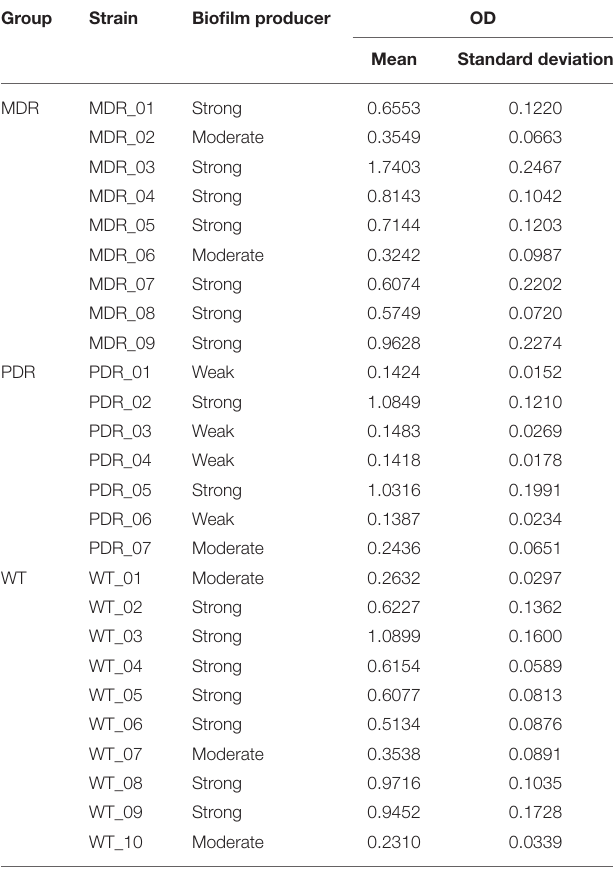
TABLE 3 | Classification of P. aeruginosa strains based on their biofilm formation ability. Group